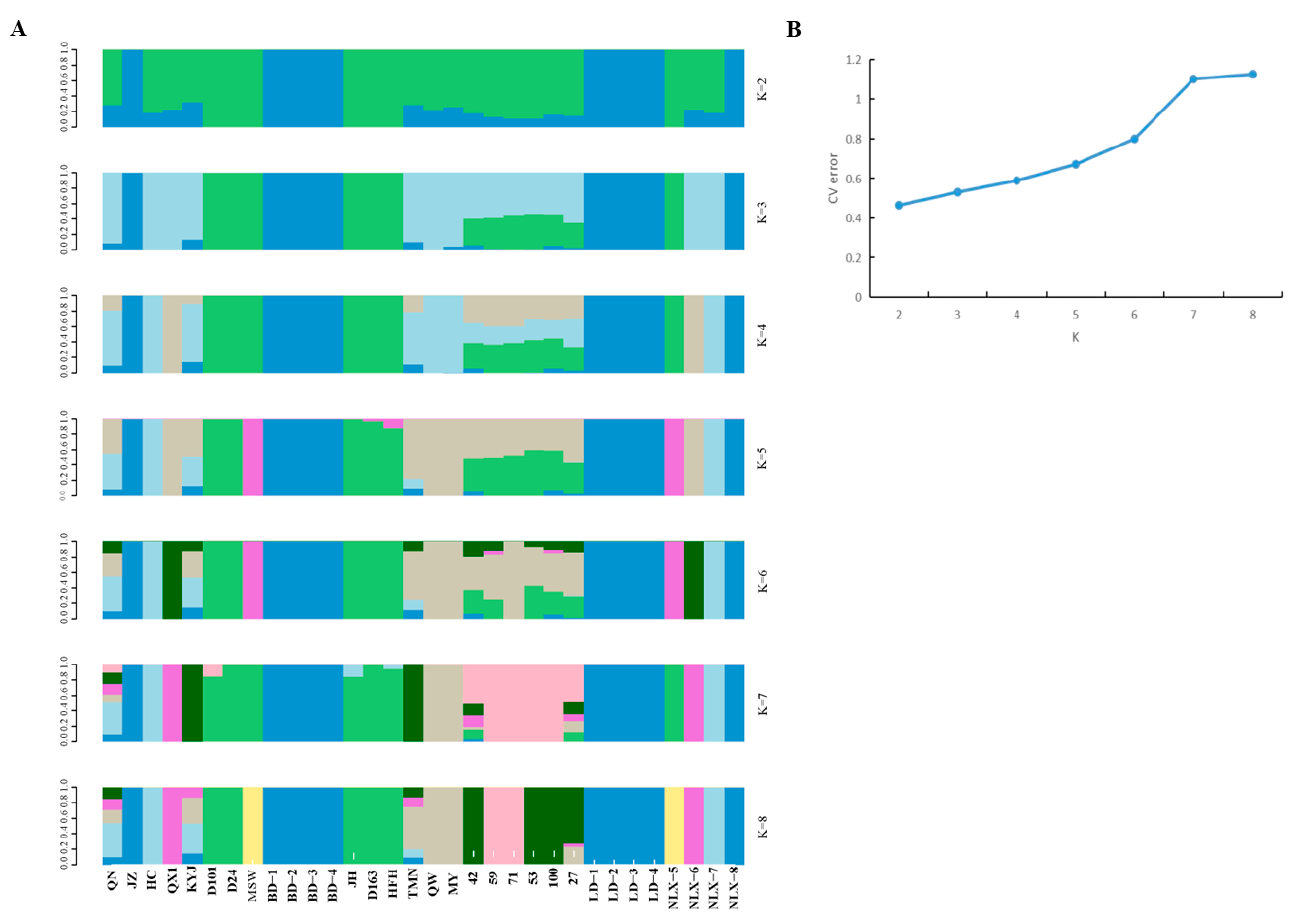
Figure 3. Bayesian model-based population structure of the 32 durian genotypes. The membership coefficient (Q) is shown by a vertical bar. The colored subsections within each vertical bar show sub-populations. ( A ). The subgroup assignment by ADMIXTURE for a set of indicators of the 32 durian accessions when K = 2–8. ( B ). The optimum K. The cross-validation (CV) error curve based on ADMIXTURE output reveals that the CV error value of 2 was the smallest at K = 2, thus dividing the 32 durian accessions into 2 groups (that is, 2 subgroups is optimal).